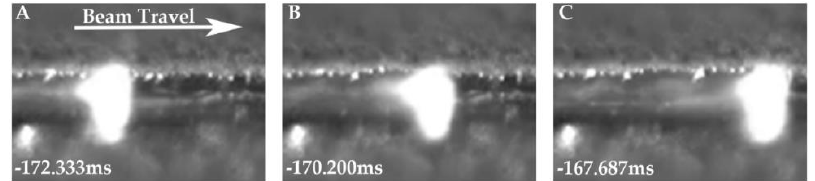
Figure 15. Representative frames of high-speed video footage showing the EB-PBF of a single layer disc on hydrogen-treated LO-Cu powder at timestamps -172.333 ms ( A ), -170.200 ms ( B ), -167.687 ms ( C ).